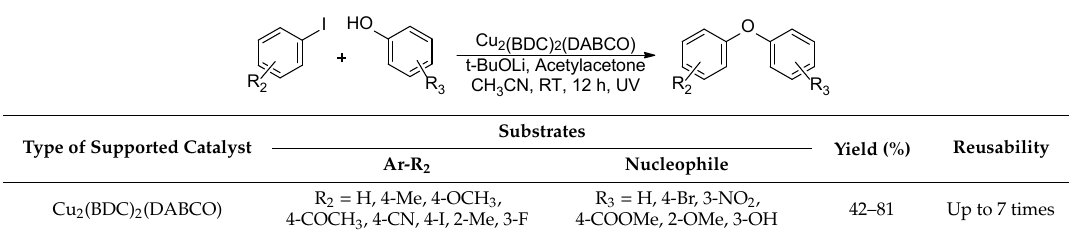
Table 7. MOF-based Cu 2 (BDC) 2 (DABCO) catalyzed synthesis of diphenyl ethers.